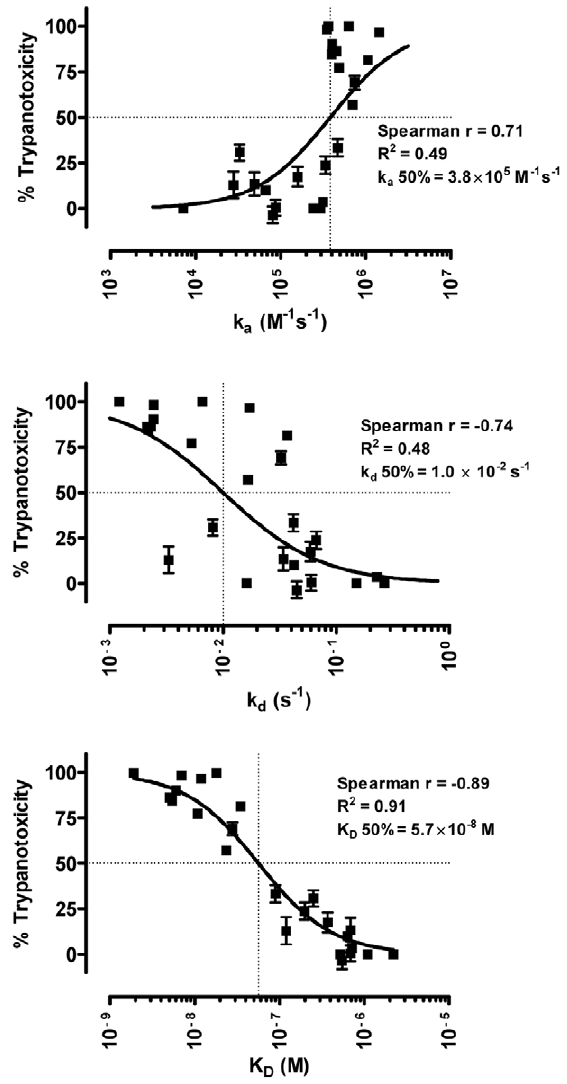
Figure 1. Functional characterization of the newly identified Nanobodies. ( A ) Flow cytometric analysis demonstrating Nanobody binding onto live bloodstream form T. brucei AnTat1.1 using a three step labeling with the Nanobody, mouse anti-6 6 His IgG and phycoerythrin conjugated rat anti-mouse IgG ( B ) Dot plot representa- tion with isoaffinity lines of the individual k a , k d and K D affinity constants of the different newly identified anti- T. brucei Nbs ( C ) T. brucei trypanotoxic activity at 37 u C measured after 18 hours with 10 and 20 m g/ml of the different Nbs in HMI-9/10%FCS medium calculated relative to the condition with a non-trypanosome specific Nb and including a buffer (PBS) control.